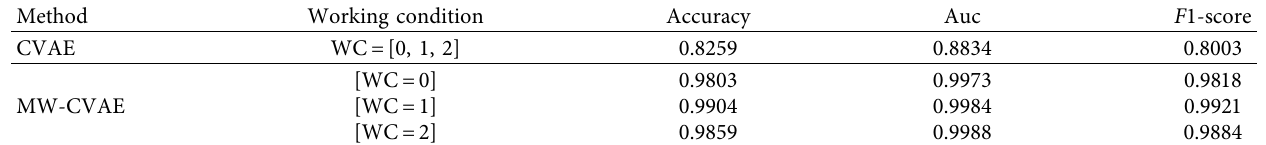
Table 6: Comparison of